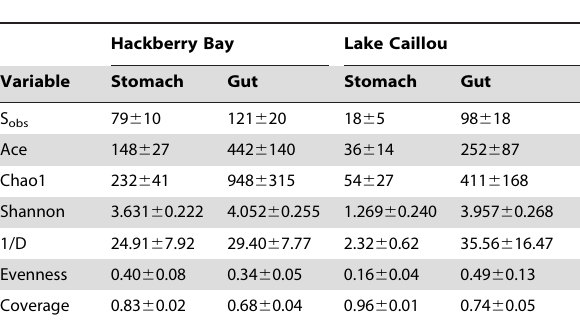
Table 5. Diversity indices for Hackberry Bay and Lake Caillou stomach and gut microbiomes at an evolutionary distance D